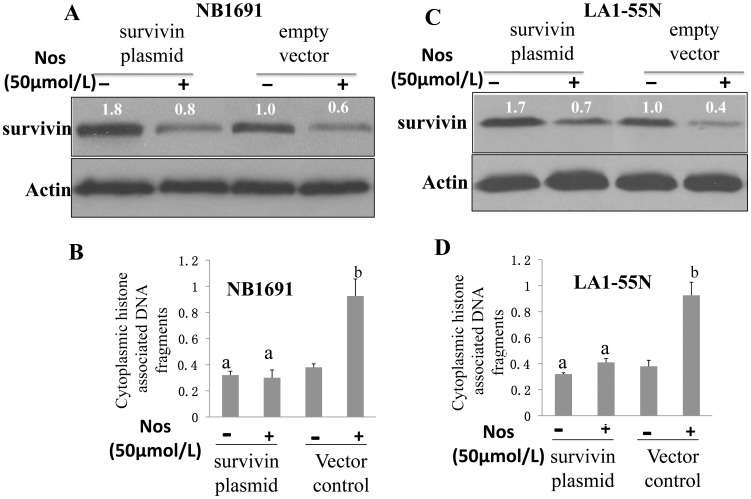
Overexpression of survivin conferred protection Noscapine-induced apoptosis.Immunoblotting for survivin protein using lysates from NB1691(A) and LA1-55N (C) cells transiently transfected with empty pcDNA3.1 vector or pcDNA3.1 vector encoding for survivin and treated for 24 h with DMSO (control) or 50 µmol/L Noscapine. The numbers above the immunoreactive bands represent change in protein level relative to empty vector–transfected cells treated with DMSO (lane 1). Cytoplasmic histone-associated apoptotic DNA fragmentation in NB1691 (B) and LA1-55N (D) cells transiently transfected with empty pcDNA3.1 vector or vector encoding for survivin and treated for 24 h with DMSO (control) or 50 µmol/L Noscapine. Columns, mean (n = 3); bars, SD. Significantly different (P<0.05) compared with empty vector–transfected cells treated with DMSO (a) and empty vector–transfected cells treated with Noscapine (b) by one-way ANOVA followed by Bonferroni’s test. Comparable results were observed in three independent experiments. Representative data from one such experiment are shown.